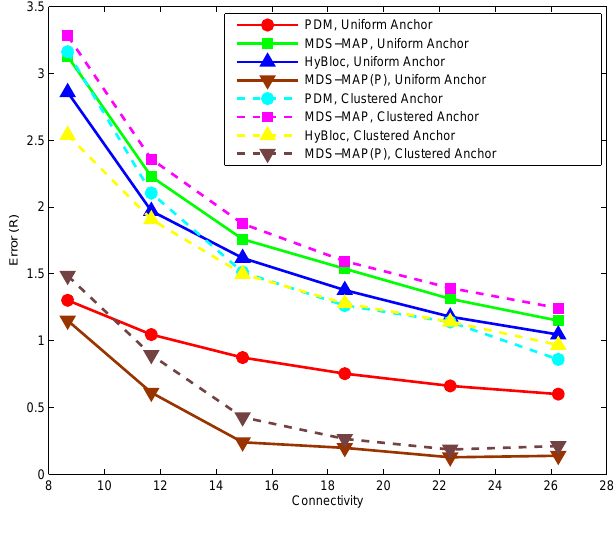
Figure 8 . C-shaped Networks, α =0.05, 5